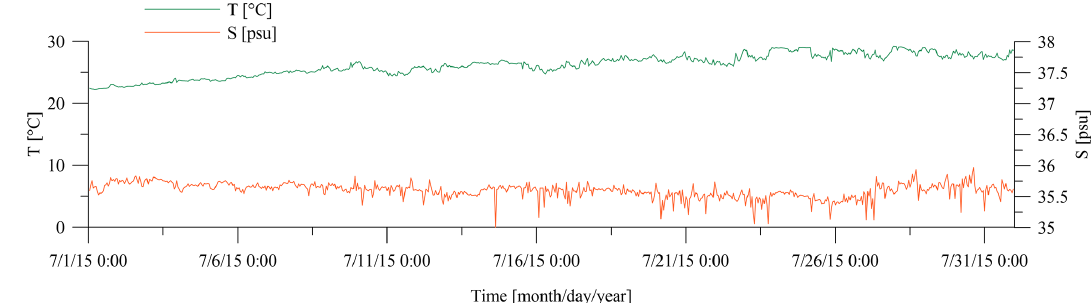
Figure 5. Time series of measured water temperature [ ◦ C] and salinity [psu] in July 2015. Time is local time.